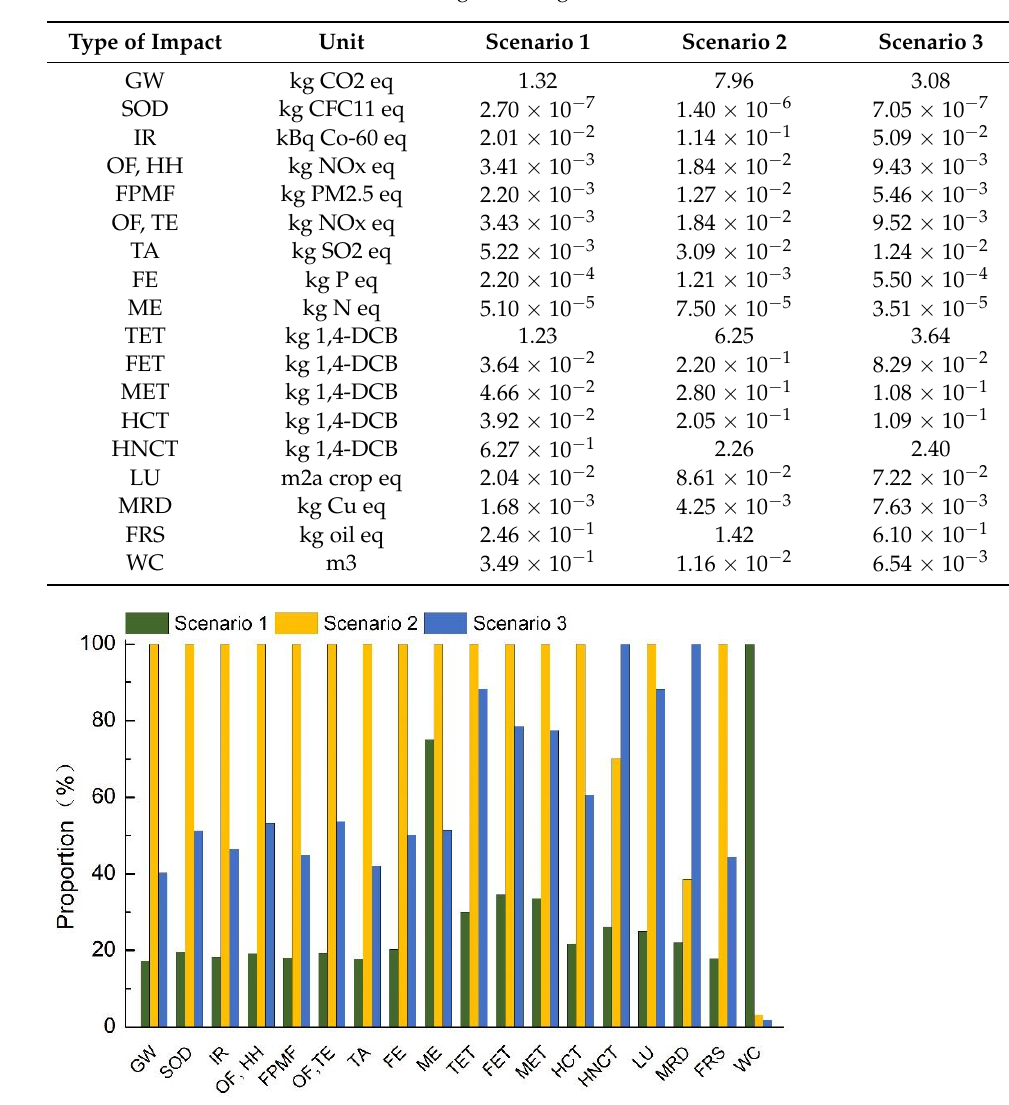
Figure 4. Characterized LCA results for the tailings discharge schemes. Under Scenario 1 (CSDT scheme), only the WC indicator was higher than that under the DSDT discharge schemes, reaching 30 times higher than that under Scenario 2 and 53 times higher than that under Scenario 3. In water-scarce areas, CSDT could significantly increase the environmental burden. The ME indicator was 32% lower than that under Sce- nario 2 and 21% higher than that under Scenario 3. The other 16 environmental impact indicators were all lower than those for the DSDT process. The results indicate that the CSDT scheme generated a lower life cycle environmental impact without considering the WC environmental impact indicators.